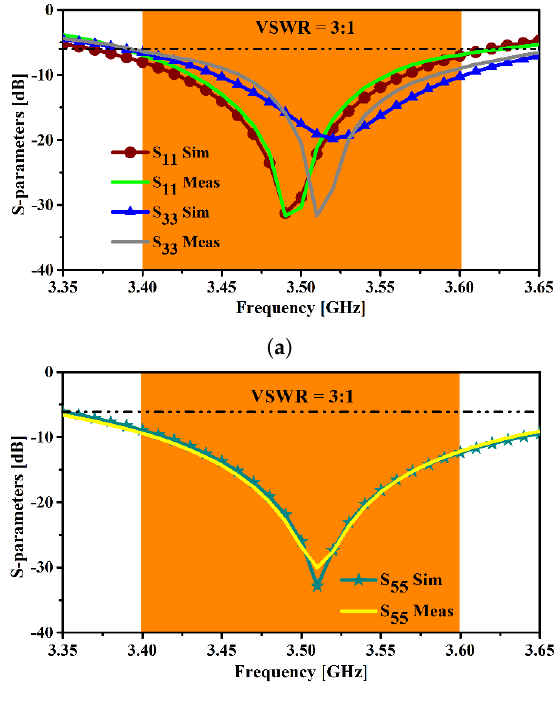
Figure 5. The S-Parameters; Simulated is denoted by (Sim) and Measured by (Meas). ( a ) Ant1 and Ant3. ( b )